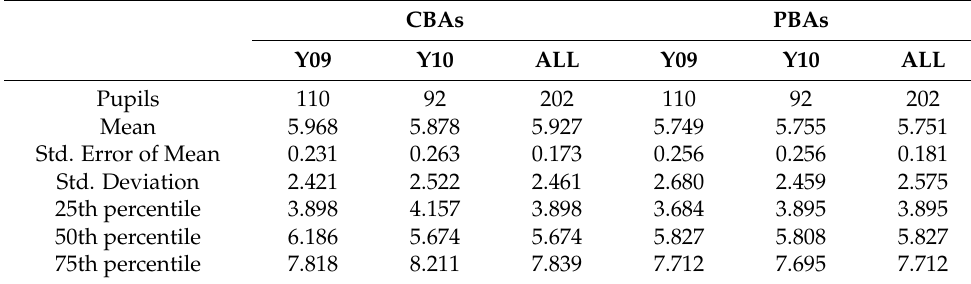
Table 4. Descriptive PRSs statistics of group ALL and cohorts Y09 and Y10 in CBA and PBA mode.